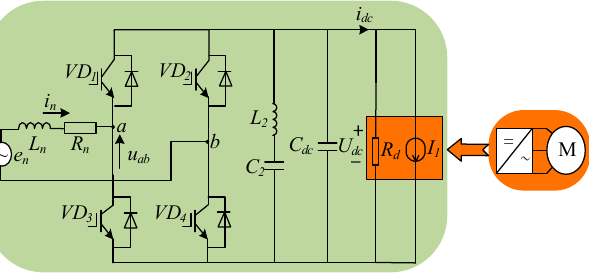
Figure 4. The equivalent schematic diagram of the traction inverter system.